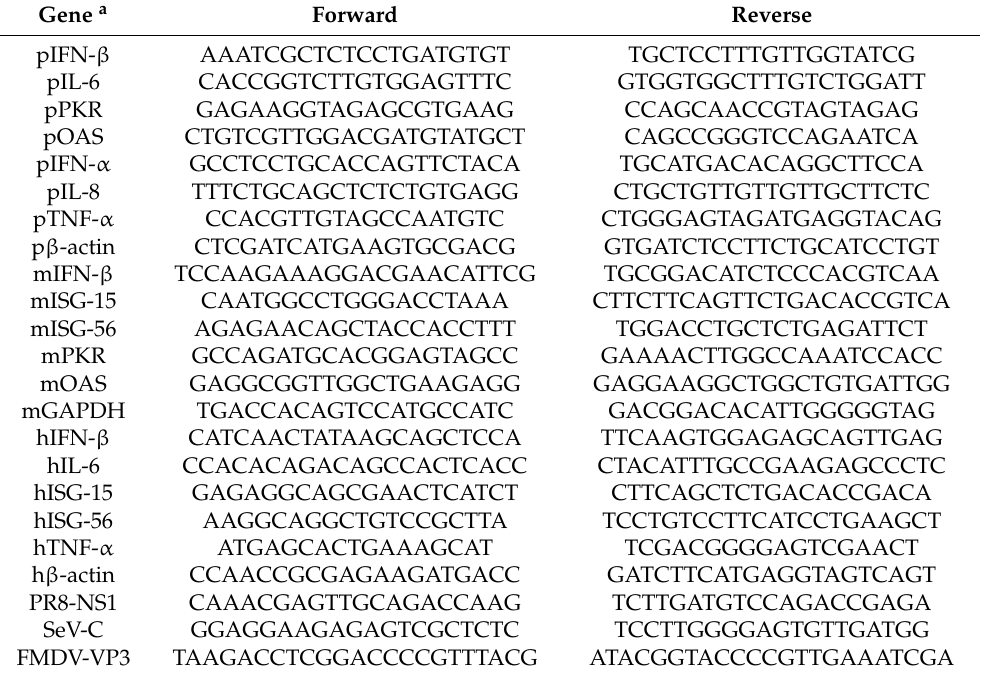
Table 1. Primers for